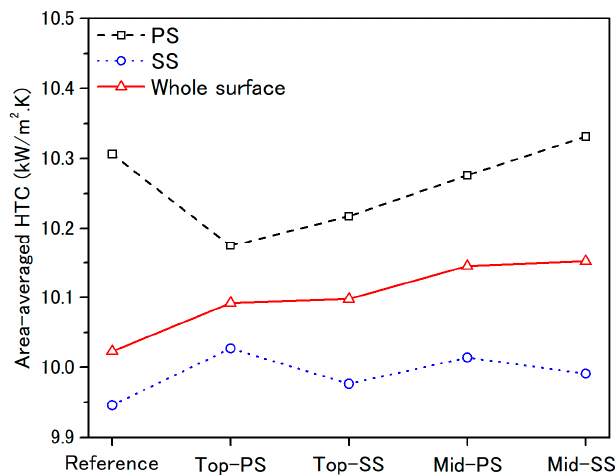
Figure 14. Area-averaged heat-transfer coefficient on the R 1 blade surface under different damaged-blade conditions.